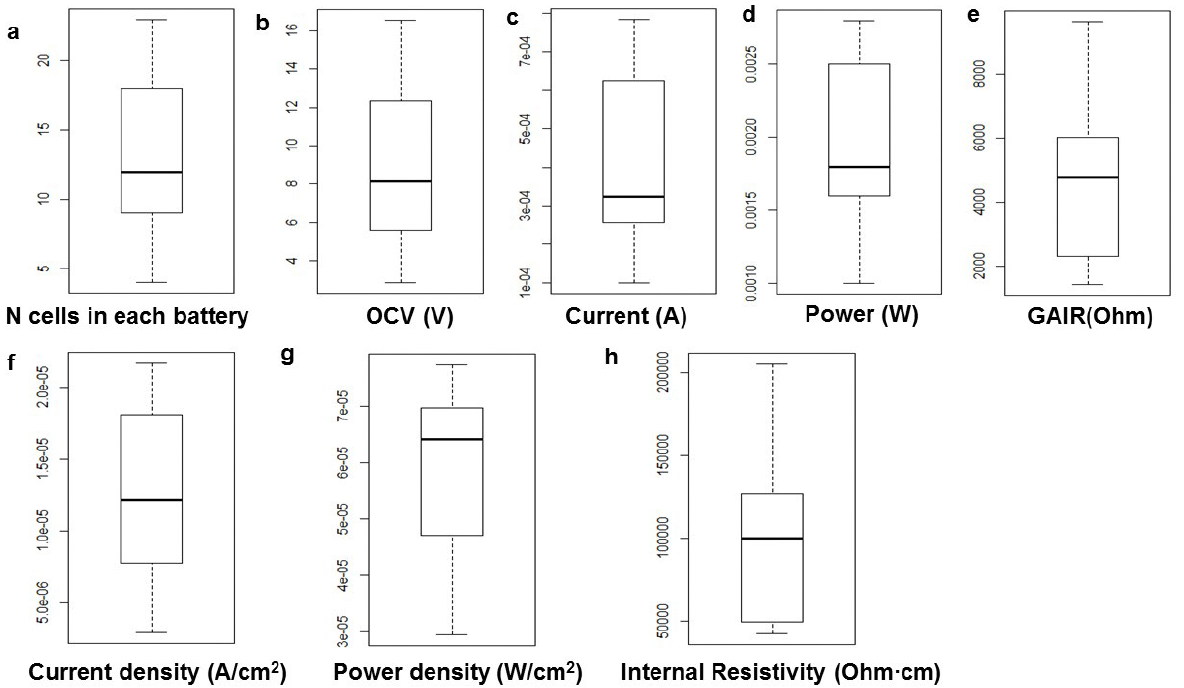
Figure 4. Distribution of assembled in competition batteries performance. ( a ) Number of cells in the final battery. ( b ) Open circuit voltage (OCV). ( c ) Current. ( d ) Power. ( e ) Galvanic apparent internal resistance (GAIR), which show how much energy is lost by battery internal resistance. ( f ) Current density. ( g ) Power density. ( h ) Internal